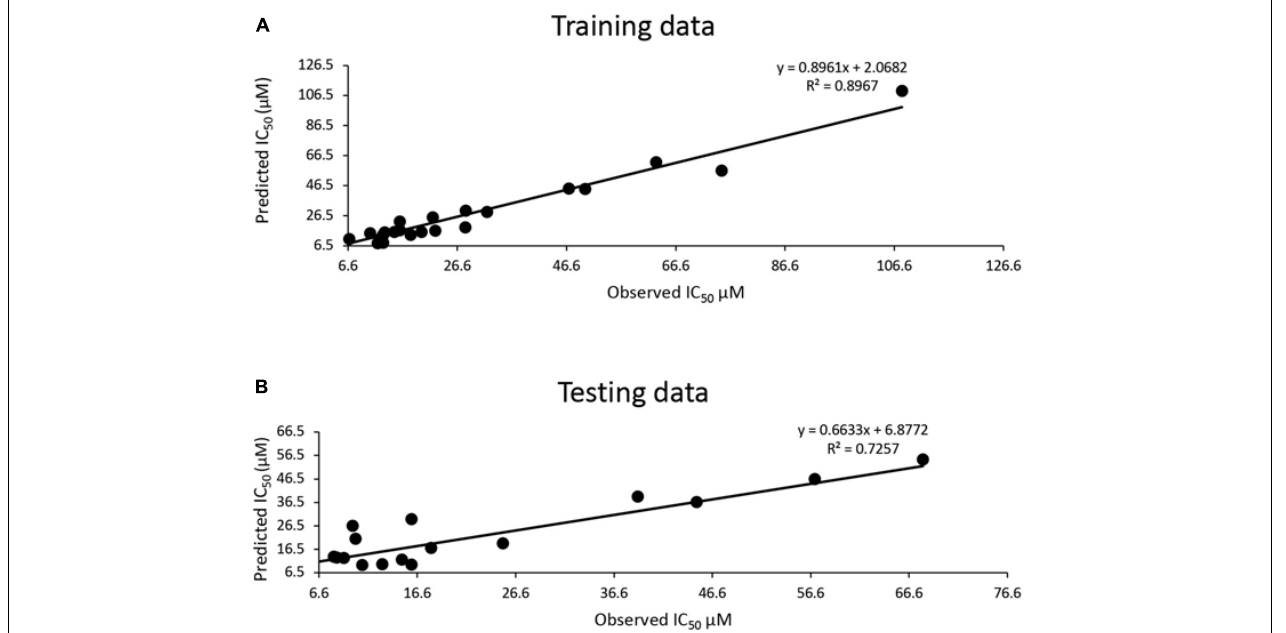
FIGURE 2 | Development of a QSAR model: (A) The QSAR model generated by the training data suggests a good fit ( R 2 = 0.9); (B) a strong correlation ( R 2 = 0.72) between actual IC 50 µ M and predicted IC 50 µ M for the test data. TABLE 1 | Newly discovered SARS-CoV-2 3CLprotease inhibitors.